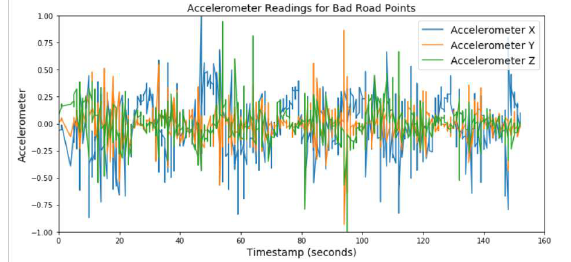
Figure 4. Accelerometer Readings for Bad Road Points